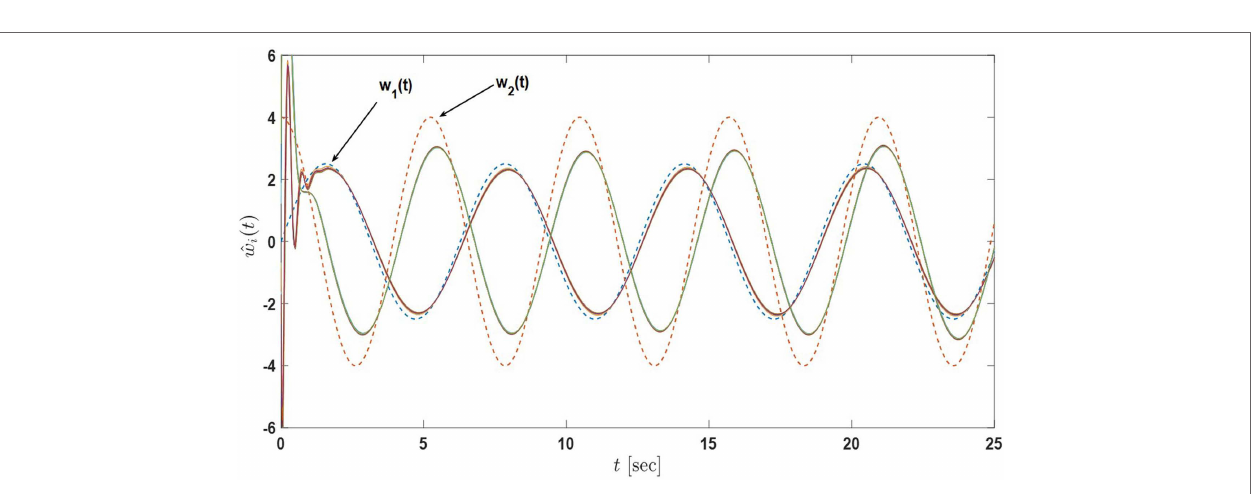
FIGURE 7 | Input estimates of the sensor network in Example 2 with 8 active nodes and 4 passive nodes under the proposed architecture equations (7) and (8) (the dash lines denote the inputs of the actual process and the solid lines denote the input estimates of nodes) Tran et al. (2017).